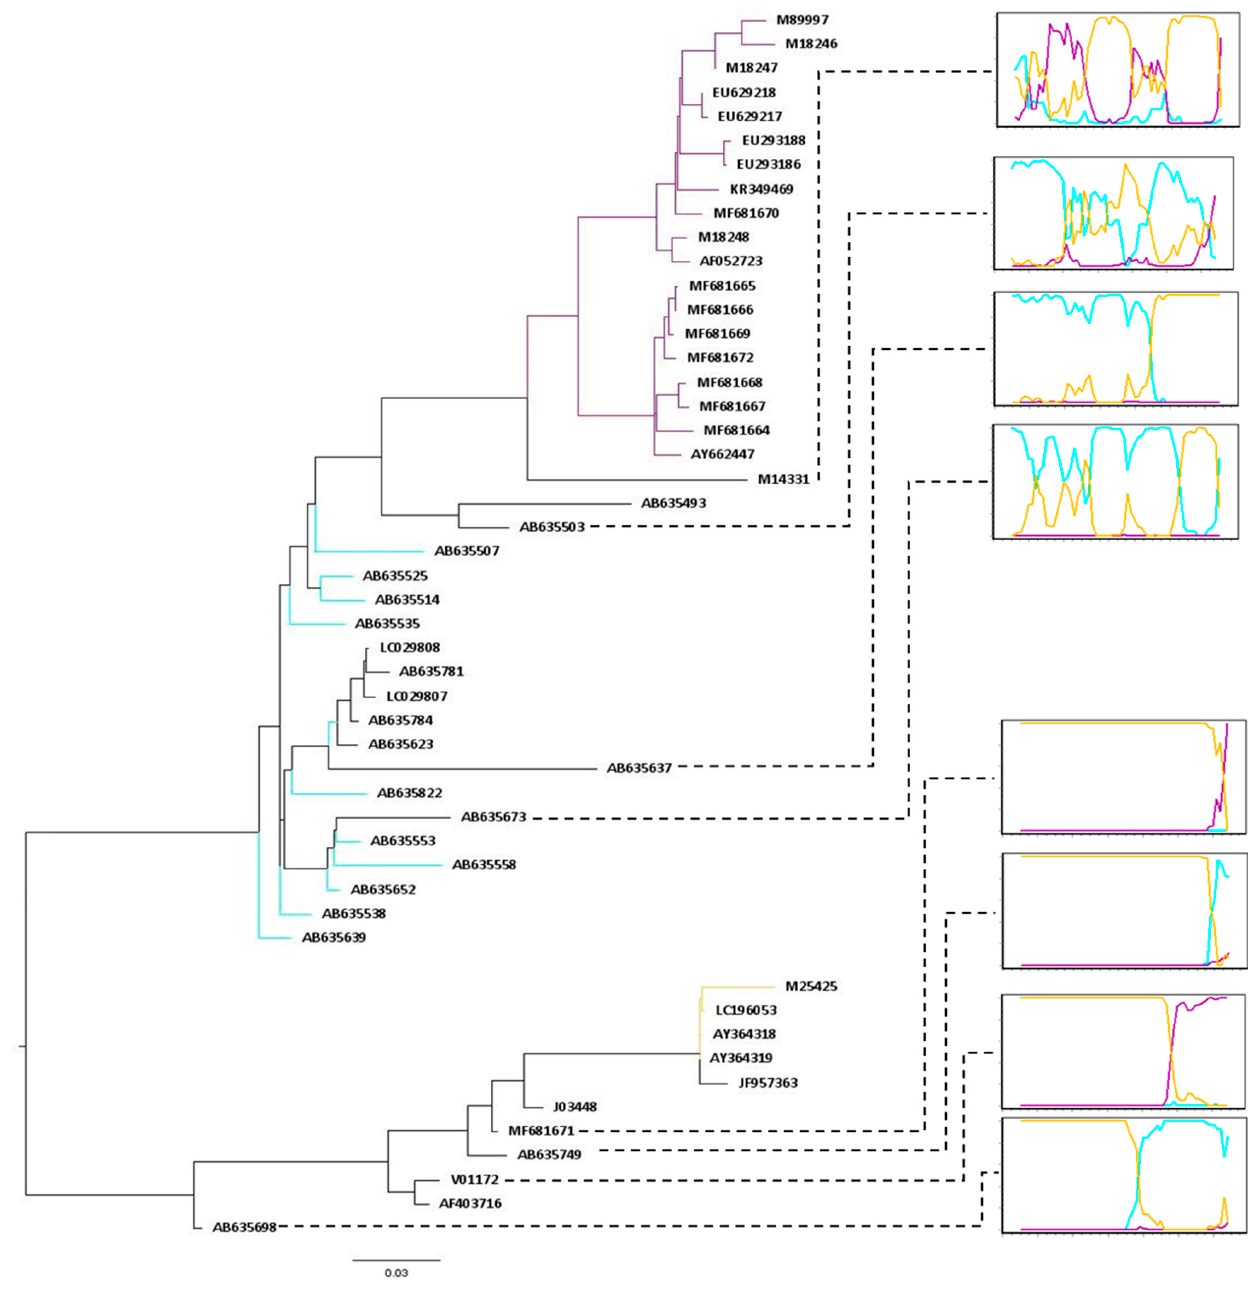
Figure 2. Bootscan of some recombinant sequences. Recombinant sequences were submitted to bootscanning analysis in Simplot 3.5.1 [32]. The Kimura 2-parameter model was used as a distance model on a sliding window of 200 nucleotides (nt) by increments of 20 nt. For the bootscan analysis, recombinant samples identified by RDP4 were used as query sequences in Simplot and, non-recombinant sequences were used as references. A phylogeny was reconstructed by using the best-fitted nucleotide substitution model (GTR + F + R5) in the IQtree web server with some recombinant sequences (AB635493, AB635503, AB635637, AB635638, AB635673, AB635698, AB635749, M14331, MF681671, and V01172) and non-recombinant sequences according to the RDP4 analyses. Branches of some non-recombinant sequences are colored according to the clades found in the Figure 4.